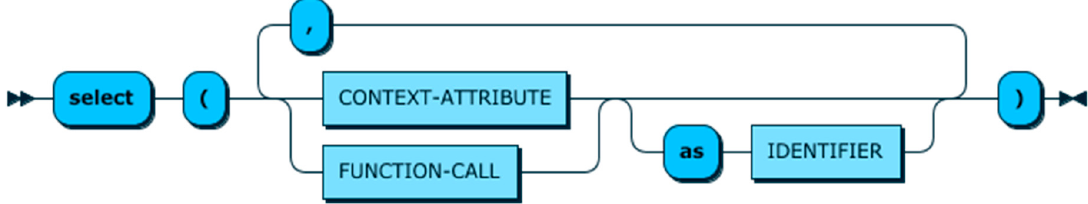
Figure 9. SELECT clause production rule.